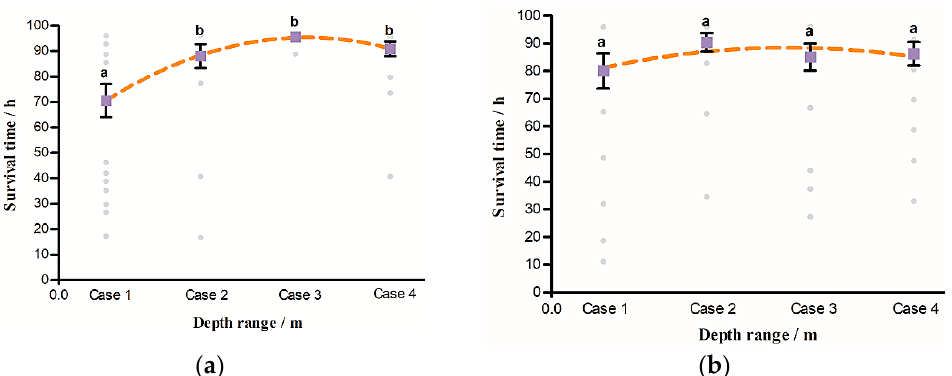
Figure 4. The survival time of test fish exposed to total dissolved gas (TDG) supersaturation at different water depths (Case 1: 0–0.3 m; Case 2: 0.3–1.3 m; Case 3: 1.3–2.3 m; Case 4: 0–2.3 m). ( a ) Procypris rabaudi ; ( b ) Myxocyprinus asiaticus . Each value is showed in terms of the mean ± S.E., n = 40. Blue dots represent the average survival time (AST) of the test fish at each water depth. Grey dots represent the survival time of each test fish. The orange line represents the best-fit regression model. Mean values are significantly different if they are not marked with the same lowercase letter ( p < 0.05). Table 3. The average survival time (AST) of juvenile Procypris rabaudi and juvenile Myxocyprinus asiaticus in the total dissolved gas (TDG)-supersaturated water at different water depths (mean ± S.E., n = 20).